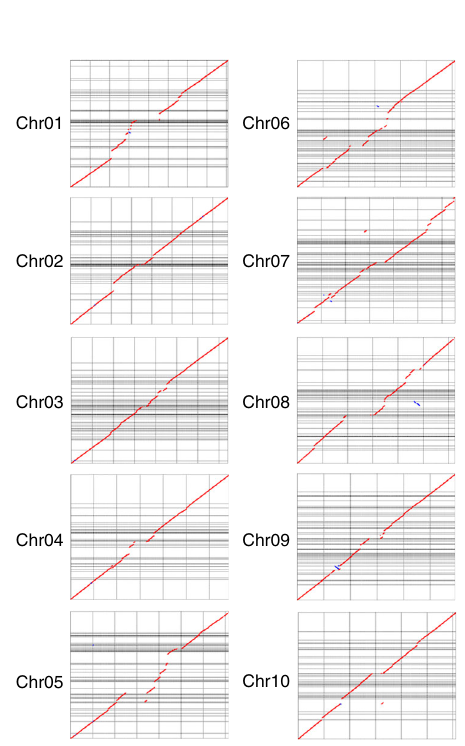
Fig. 1 MUMmerplot comparison of Tx430 ONT assembly with the BTx623 reference assembly. ONT contigs ( Y -axis) ( Tx430 ) were aligned to all 10 chromosomes from the public BTx623 v3.0.1 genome assembly ( X - axis) ( BTx623) with NUCmer, and results were subsequently fi ltered for